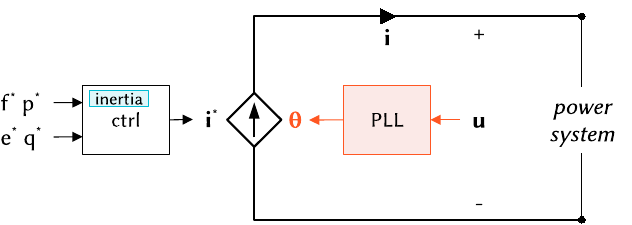
Figure 1. Fundamental representation of grid-following synchronisation mechanism and controls with inertia